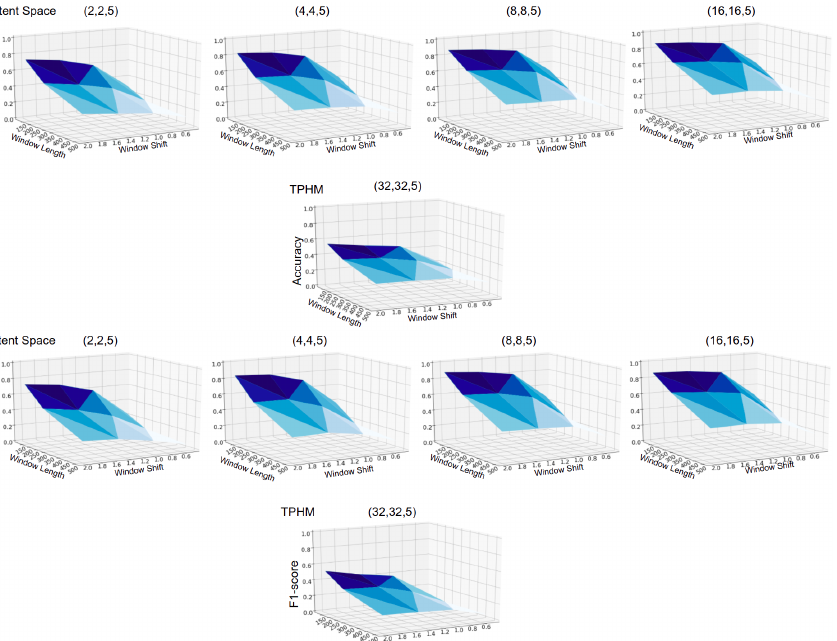
Figure 7. 3D plot depicting mean Utility (U) scores (Accuracy, F1-score) for 60 different DNN models with varying window length (WL), window shift (WS), and two kinds of input viz latent space (LS) and Topology Preserved Head-Maps